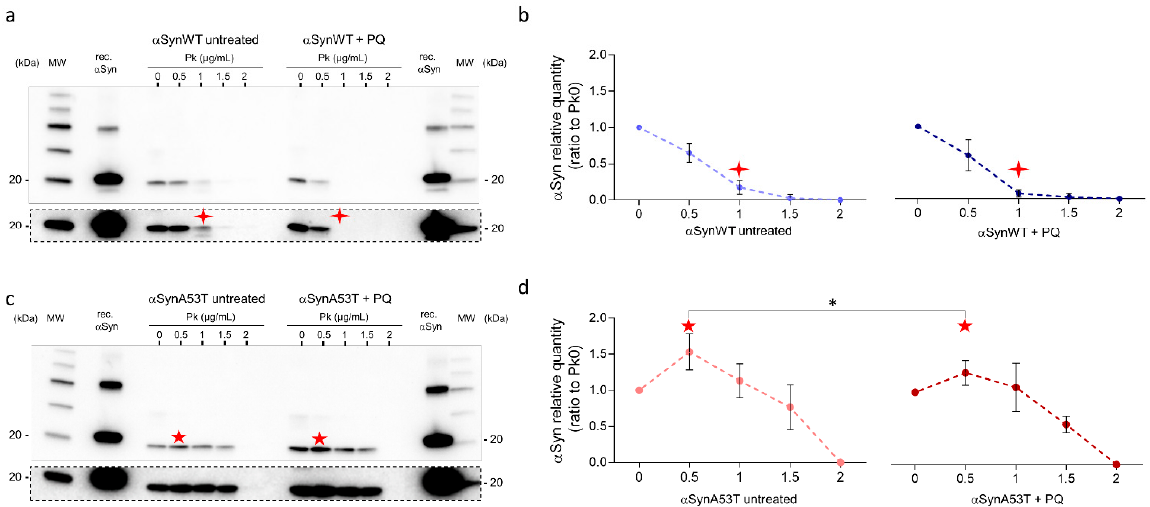
Figure 7. Fly chronic exposure to PQ promotes α Syn proteinase-K-sensitive forms. Heads (n = 100) from α SynWT ( a , b ) and α SynA53T expressing flies ( c , d ) at LT50 were digested with proteinase-K (PK) (25 ◦ C, 30 min) at increasing concentrations and analyzed by Western blot with an anti- α Syn (MJFR1) antibody. Cropped images surrounded by dashed lines from the corresponding condition gel with a longer exposition are shown below each gel. Densitometric analyses ( b , d ) are indicative of 10 independent experiments corresponding to: untreated α SynWT (n = 4), PQ α SynWT (n = 4), untreated α SynA53T (n = 6), and PQ α SynA53T (n = 7). Red stars show the modifications of the PK digestion profile observed in α SynWT (four-pointed stars) or α SynA53T (five-pointed stars) expressing flies. p -values of the group differences were calculated using t -test (* p = 0.0470).